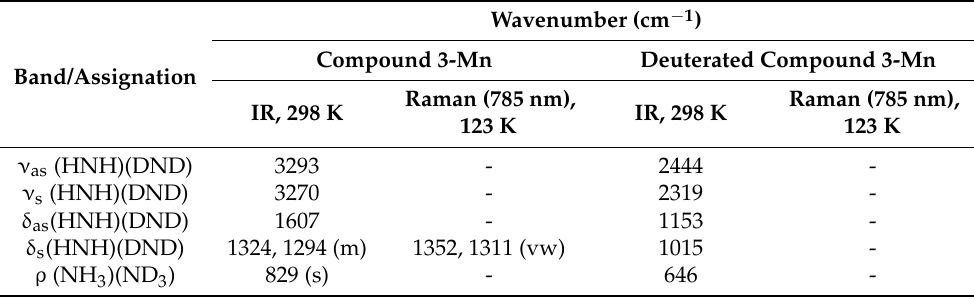
Table 4. The IR and Raman spectra of the ammonia ligand in [Co(NH 3 ) 5 Cl](MnO 4 ) 2 ( compound 3-Mn ) and its deuterated